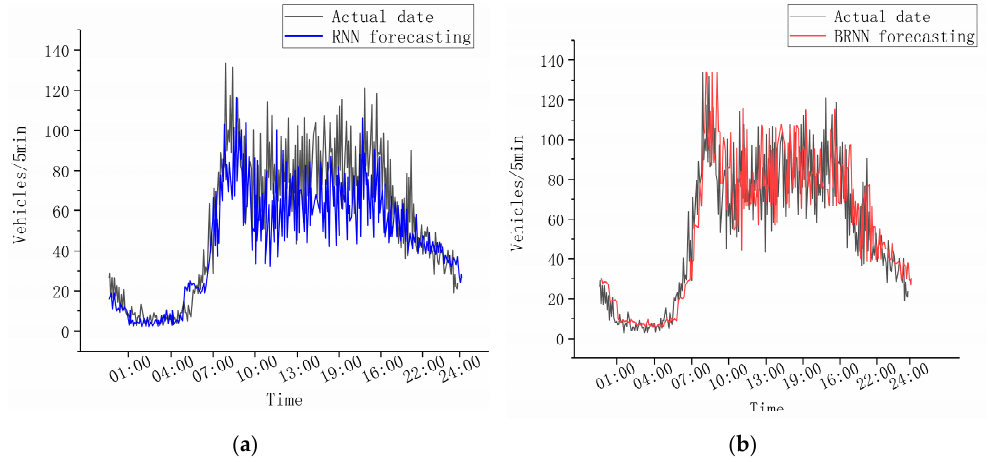
Figure 10. This is the model prediction curves of RNN and BRNN. This first graph ( a ) is the comparison diagram of real traffic flow and predicted traffic flow by RNN, while the second ( b ) is the comparison diagram of real traffic flow and predicted traffic flow by BRNN.